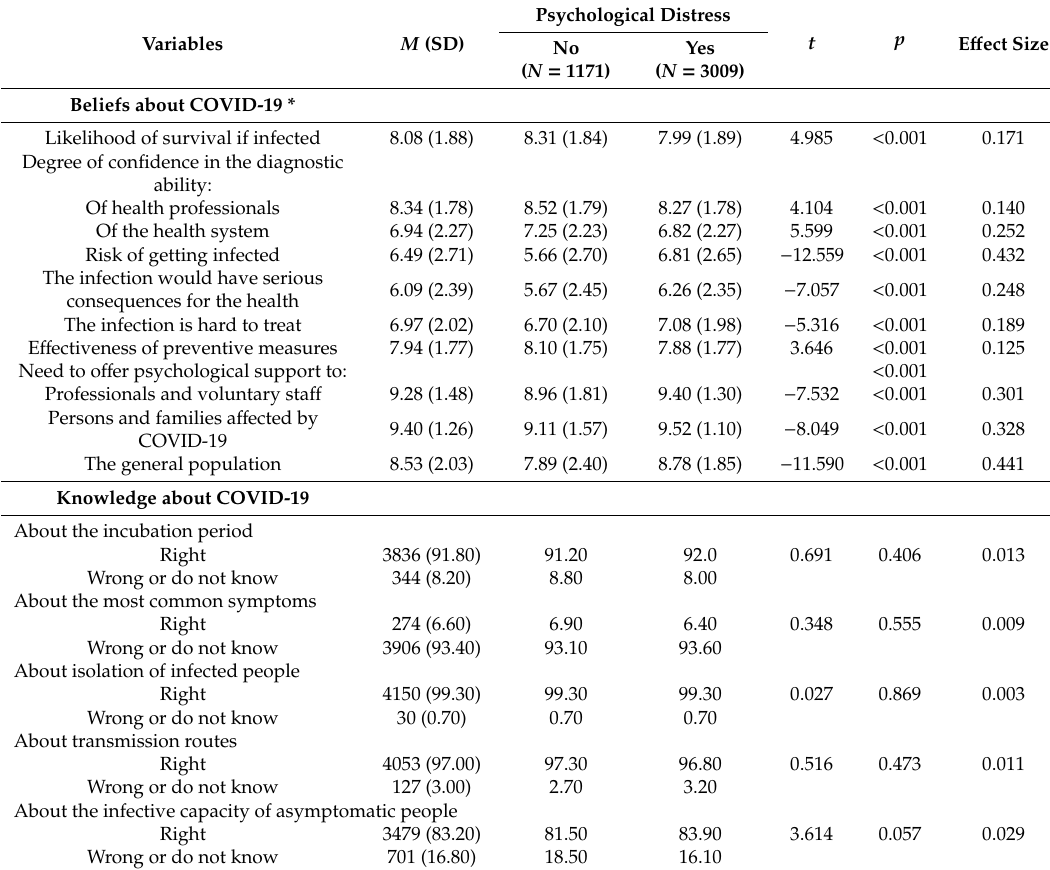
Table 5. Association between beliefs and knowledge about COVID-19 and psychological distress during the pandemic ( n =